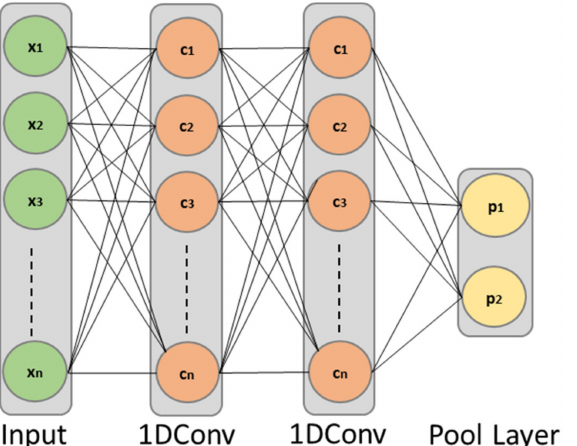
Figure 4. One-dimensional (1D) convolutional neural network (CNN) representation, which includes input, convolutional, and pooling